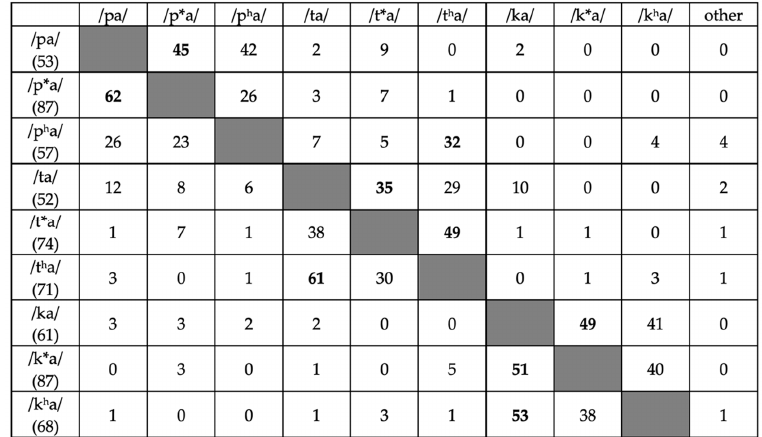
Figure 5. Confusion matrix of errors in the posttest for stop items (vertical = stimuli, horizontal = responses). Each cell shows the percentage of all errors on the given stimulus represented by the given response (rows may not add to 100% due to rounding); the most common error type for each stimulus is bolded. The total number of errors for each stimulus (across all groups) is shown in parentheses.